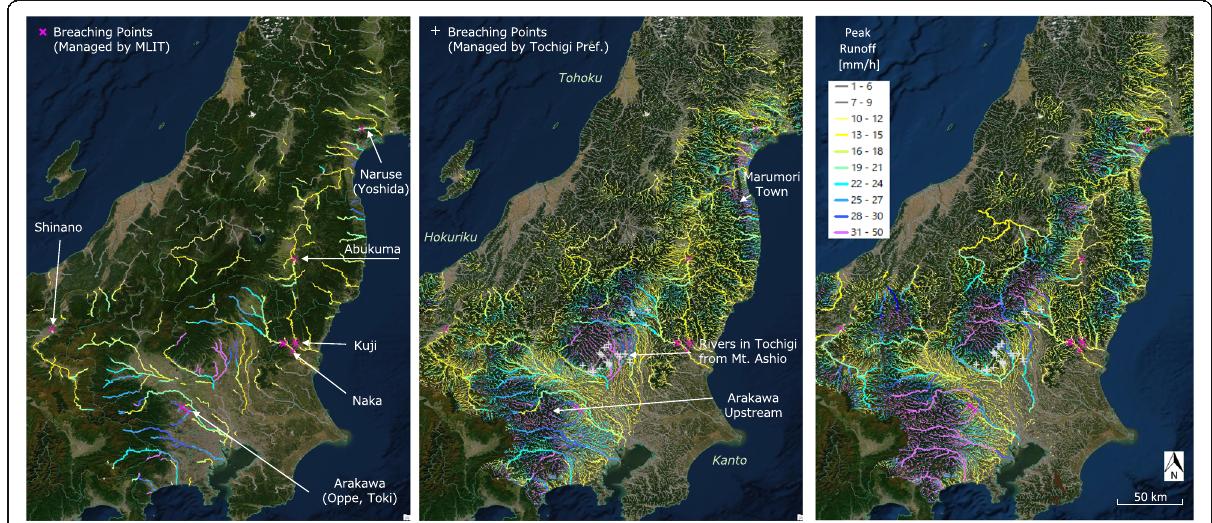
Fig. 7 The same graph as Fig. 6 but for T19. The figures also show the major levee breaching points (red marks) and levee breaching points including small tributaries in Tochigi Prefecture (white